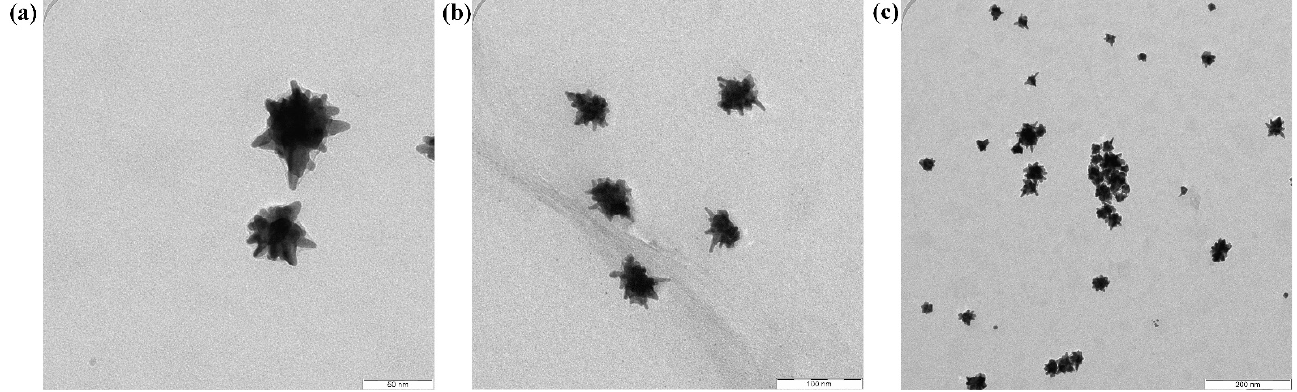
Figure 3. TEM images of Au@Ag NPs with ( a ) 50 nm scale, ( b ) 100 nm scale, and ( c ) 200 nm scale.